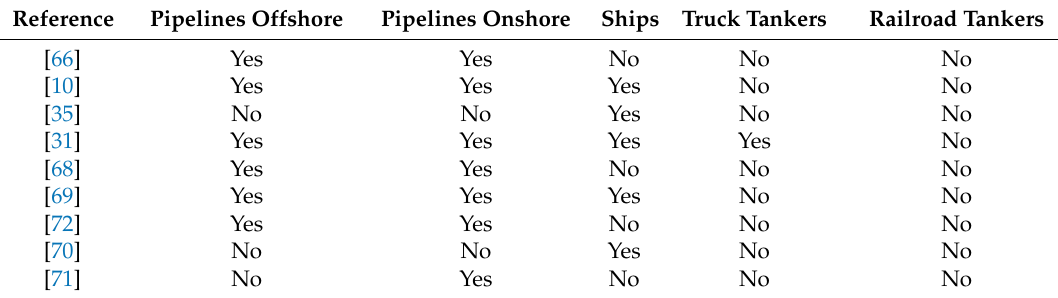
Table 3. Type of transportation examined in previous published